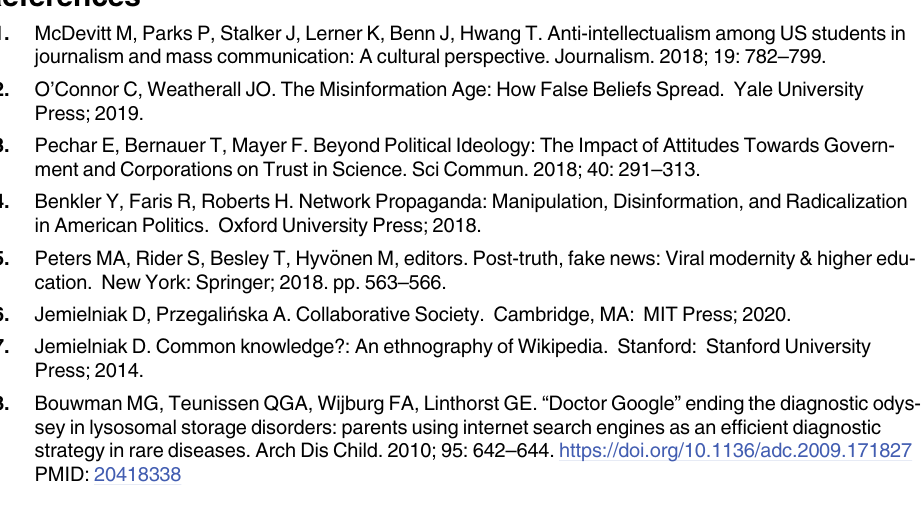
S1 Table. List of word pairs from the classic N400 paradigm (translated from